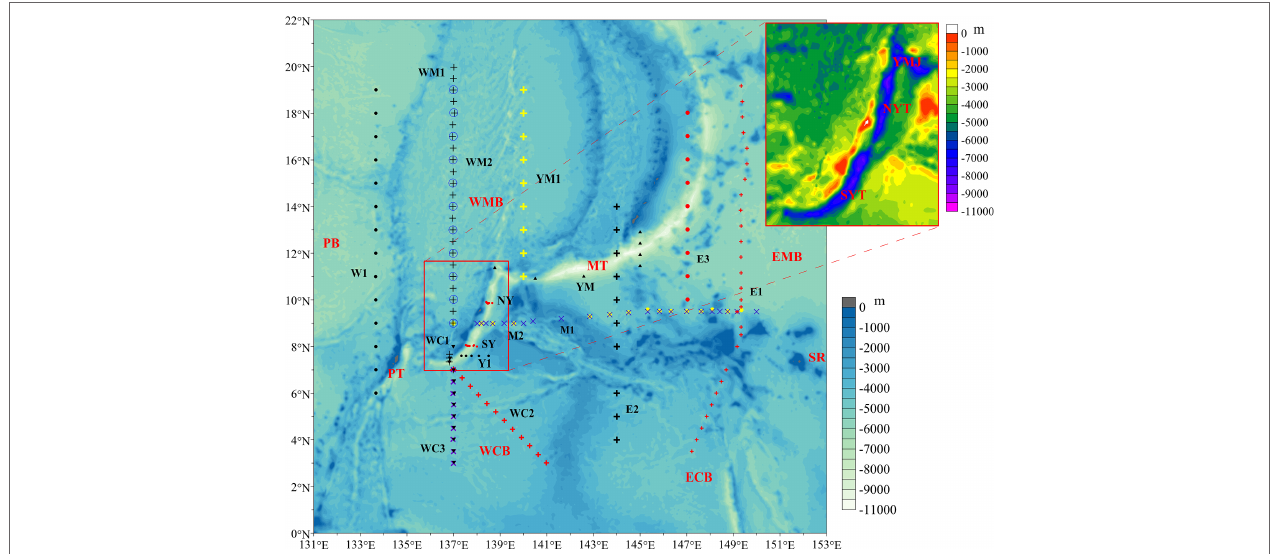
FIGURE 1 | Bathymetry and sampling sections in the Yap Trench (YT) and adjacent regions. SYT, the southern YT; NYT, the northern YT; MT, Mariana Trench; YMJ, Yap-Mariana Junction; PT, Palau Trench; WCB, West Caroline Basin; ECB, East Caroline Basin; WMB, West Mariana Basin; EMB, East Mariana Basin; PB, Philippine Basin; SR, Solomon Rise. Nos. 37–38 cruise sections: NY, SY. WOD sections: zonal Y1 in SYT and WCB; zonal M1 (blue cross marks) and M2 (yellow dots) across the middle YT, the channel, and EMB; YM (black triangles), a zonal/meridional section across MT; YM1, at 140°E in MT and WMB; W1, at 134°E in PB; WM1 (black crosses), in WMB across SYT; WM2 (blue circles), at 137°E in WMB; WC1 (inverted black triangles) along 137°E across SYT and WCB; WC2 (red crosses), in WCB; WC3 (purple crosses) at 137°E in WCB; E1 (red crosses), in EMB and ECB; E2, at 144°E in ECB across MT; E3, in EMB across MT.